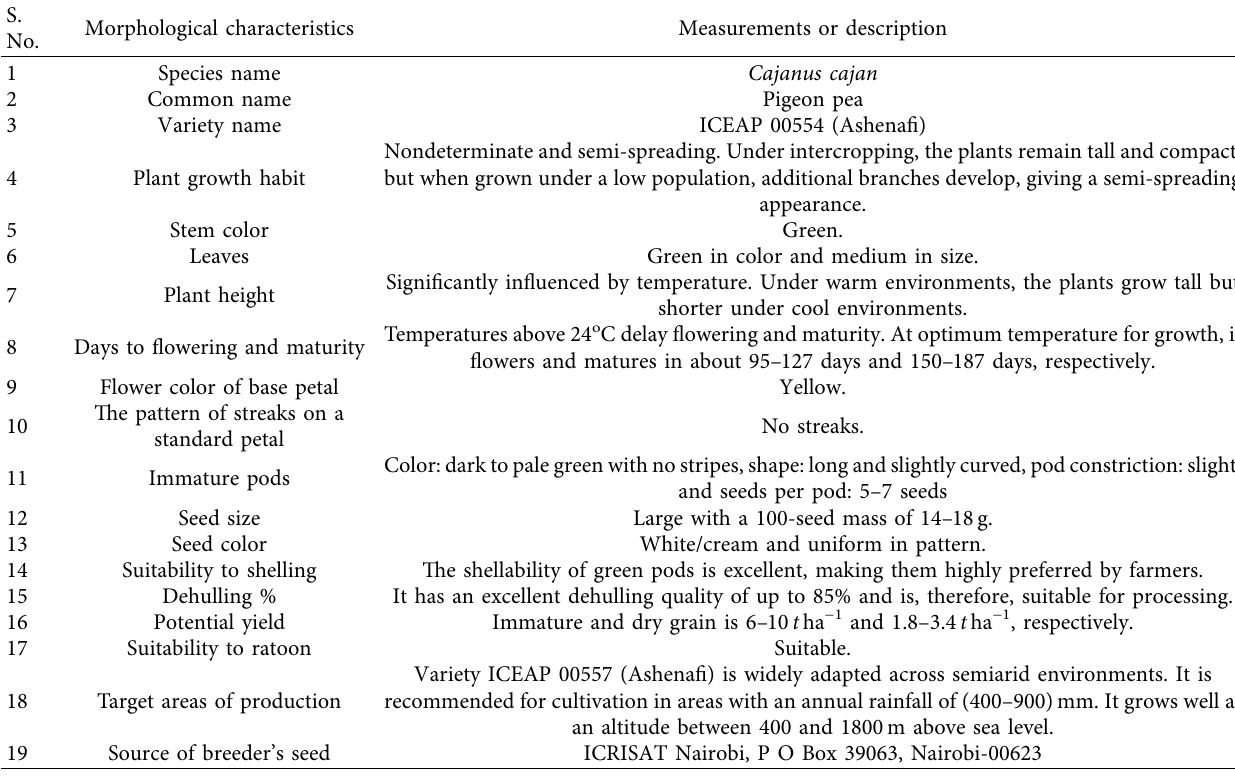
Table 7: Morphological characteristics of the variety Ashenafi (ICEAP 0055).